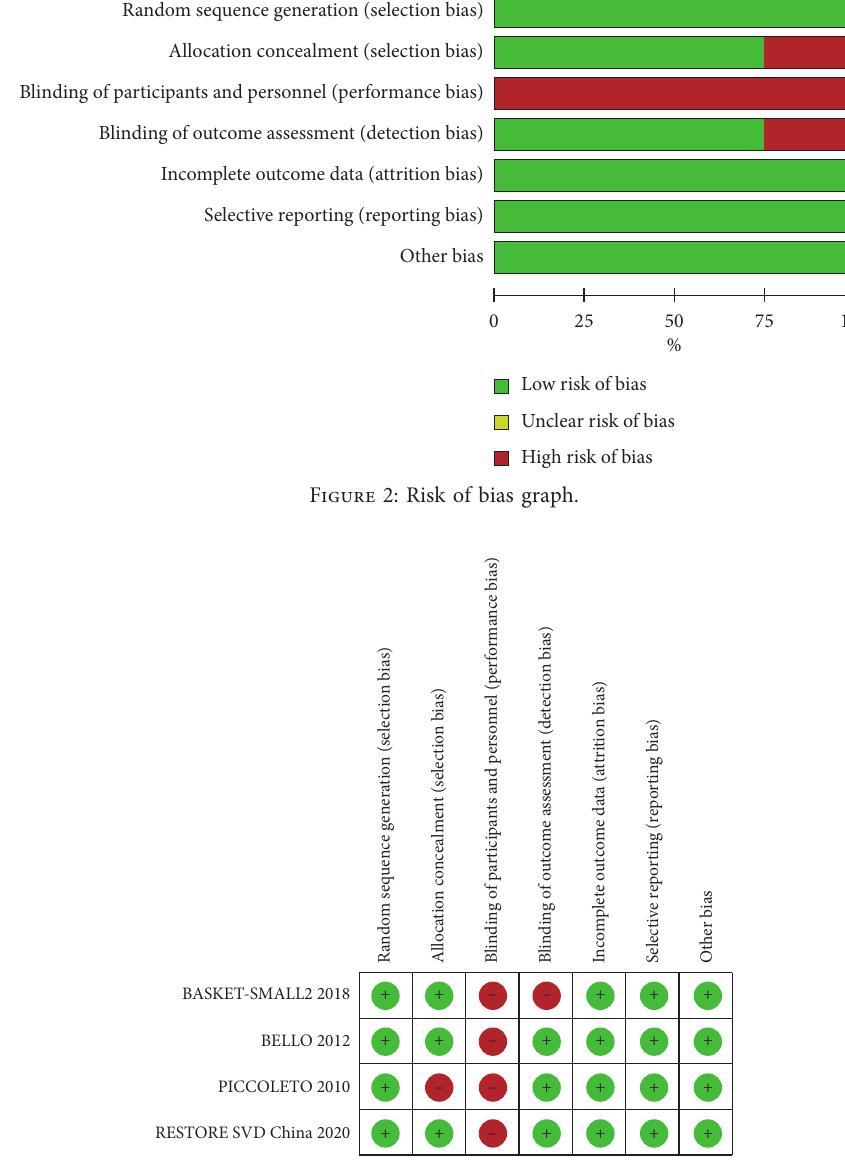
Figure 3: Risk of bias